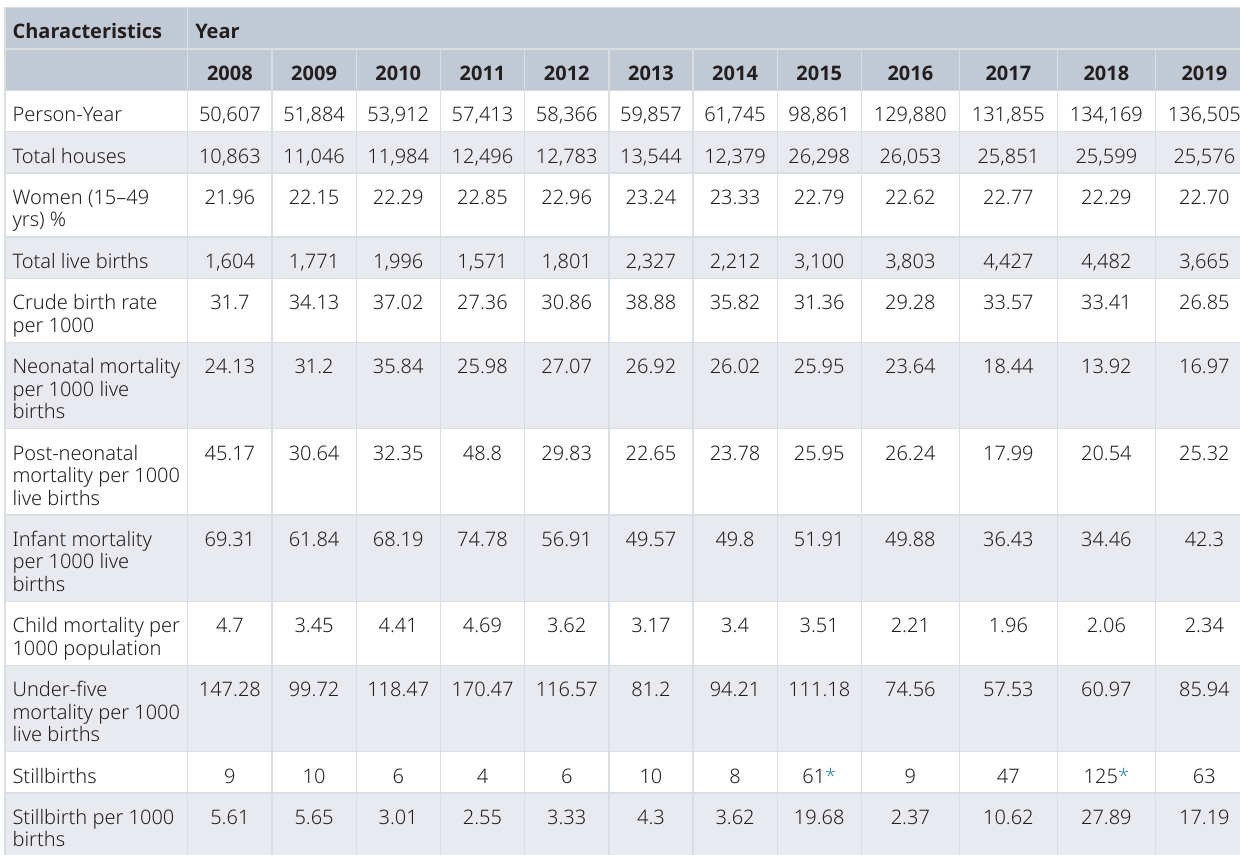
Table 1. Kersa DSS Characteristics.